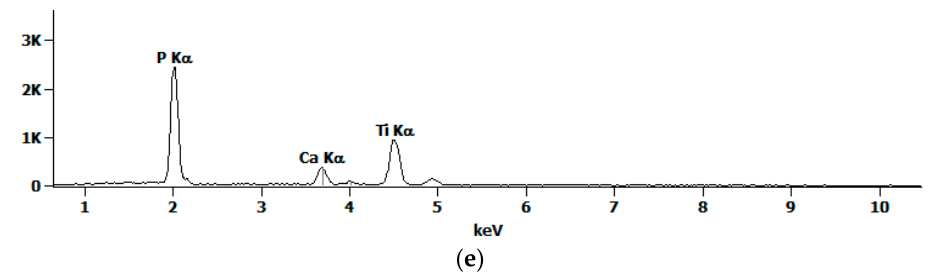
Figure 6 . SEM pictures ( a – d ) and EDS spectrum ( e ) of the porous coating formed on CP Titanium Grade 2 after PEO treatment at a voltage of 500 V DC in 500 g Ca(NO 3 ) 2 · 4H 2 O in 1000 mL H 3 PO 4 electrolyte. Magnifications: ( a ) 500×, ( b ) 1000×, ( c ) 5000×, ( d ) 10,000×.